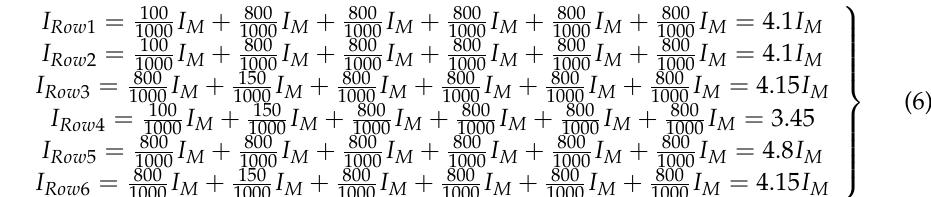
rows of TCT, static electrical reconfiguration and the two-step approach are summarized